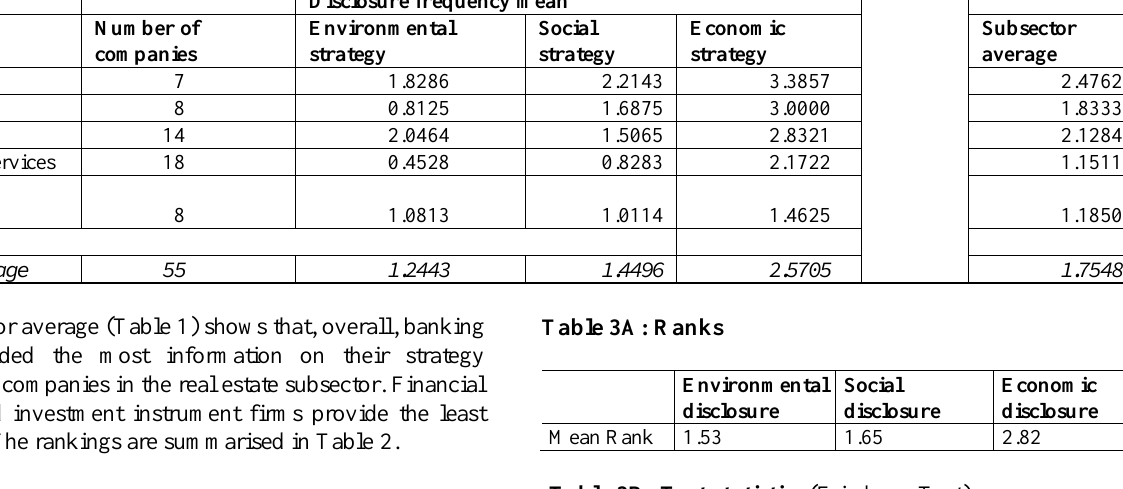
Table 3B: Test statistics (Friedman Test)